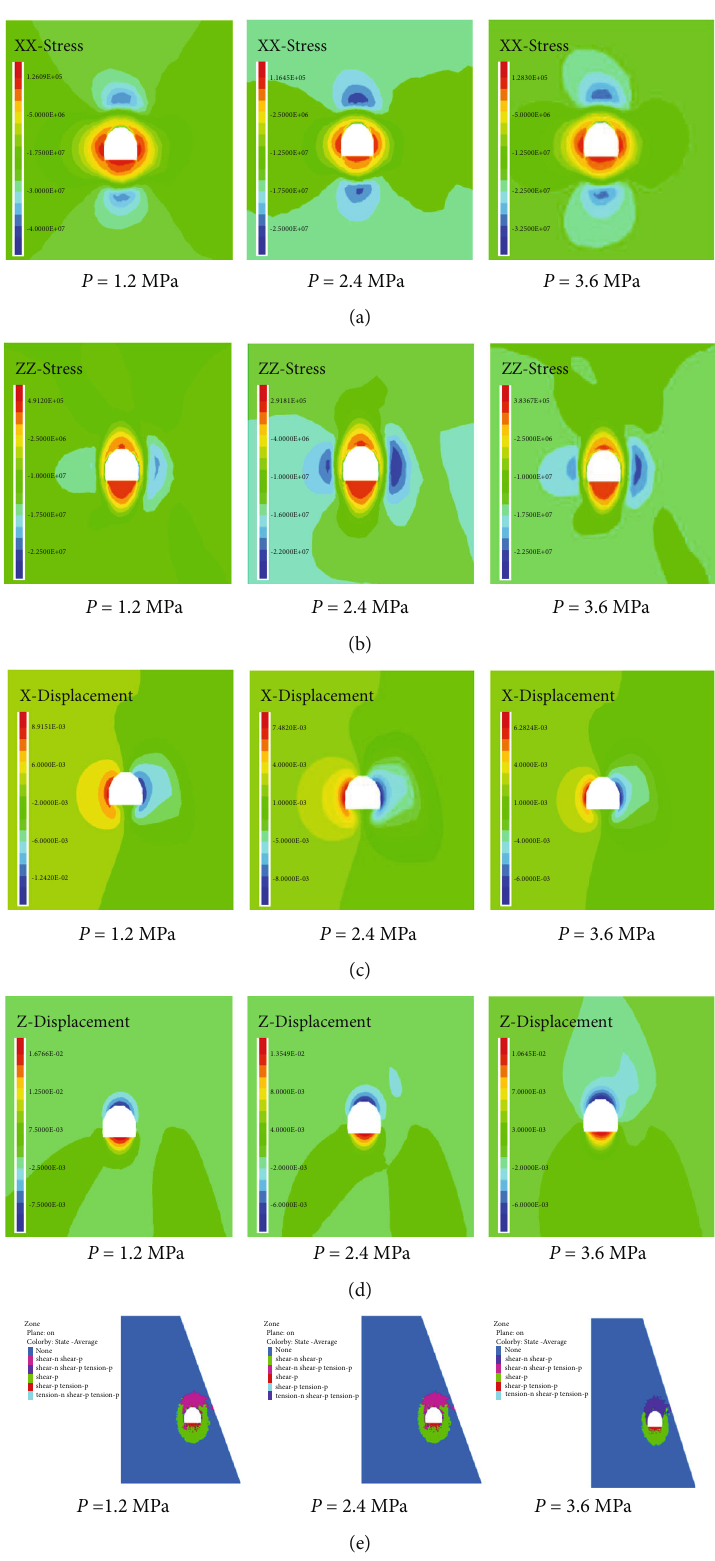
Figure 7: Calculation cloud diagram of the tunnel section under di ff erent water pressures. (a) Horizontal stress. (b) Vertical stress. (c) Horizontal displacement. (d) Vertical displacement. (e) Plastic zone limit